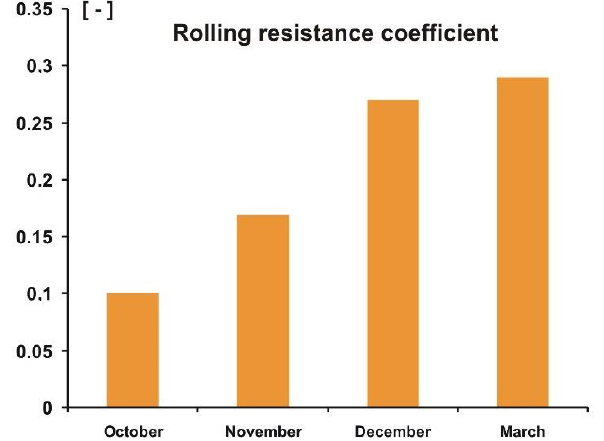
Figure 14. Average peak values of rolling resistance coefficient, k RR , for the four measurements.